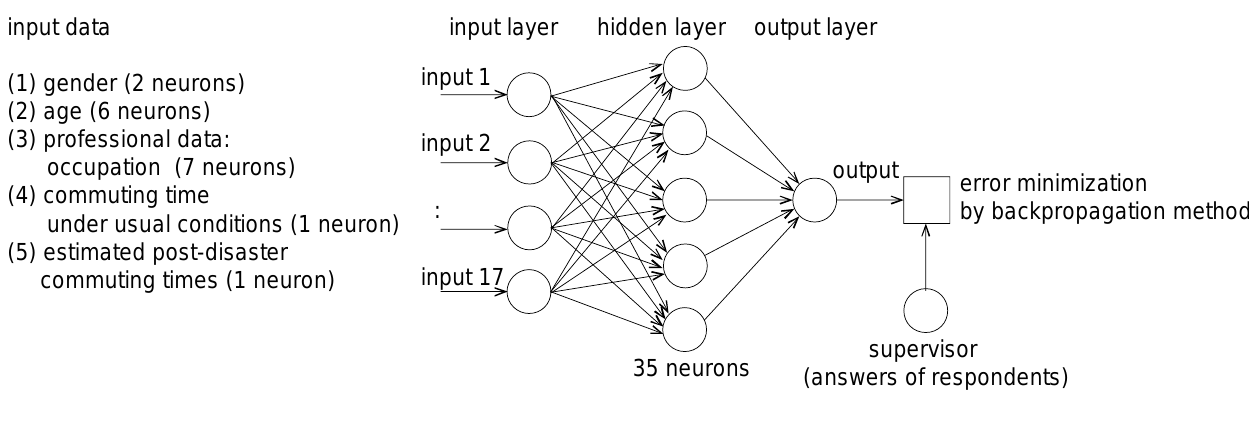
Figure 4. Structure of commuting intention: three-layer perceptron.